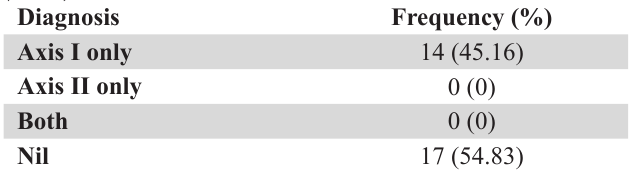
Table 1. Comorbidity profile in alcohol dependent patients